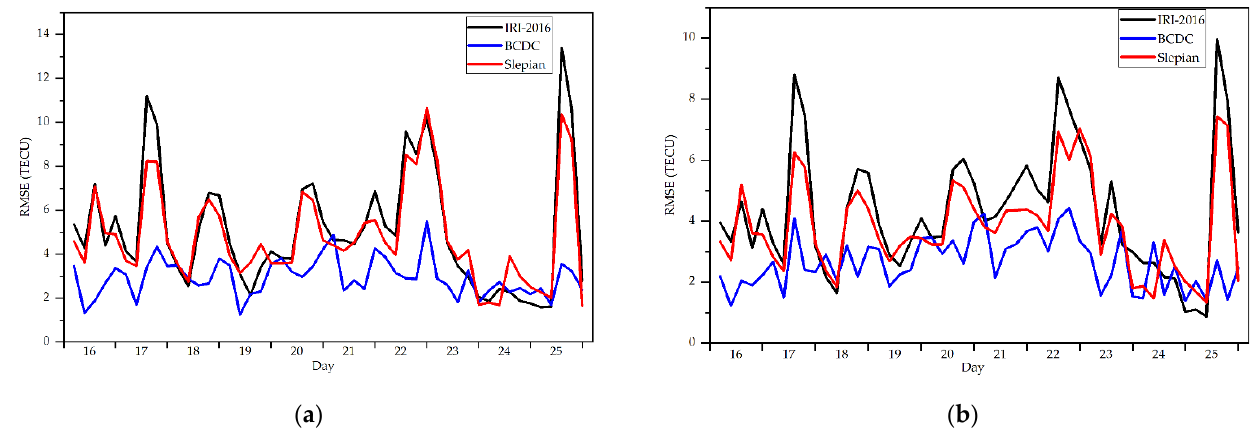
Figure 11. The RMSE (unit: TECU) of the VTEC produced by the BCDC method, the Slepian method and the IRI − 2016 model at each moment by taking the VTEC produced by IGS and UPC as truths. ( a ) IGS as the truth; ( b ) UPC as the truth. Table 4. The overall RMSE (unit: TECU) and the ∆𝑅𝑀𝑆𝐸 of the VTEC derived by the BCDC, the IRI − 2016, and the Slepian method with respect to UPC and IGS respectively.